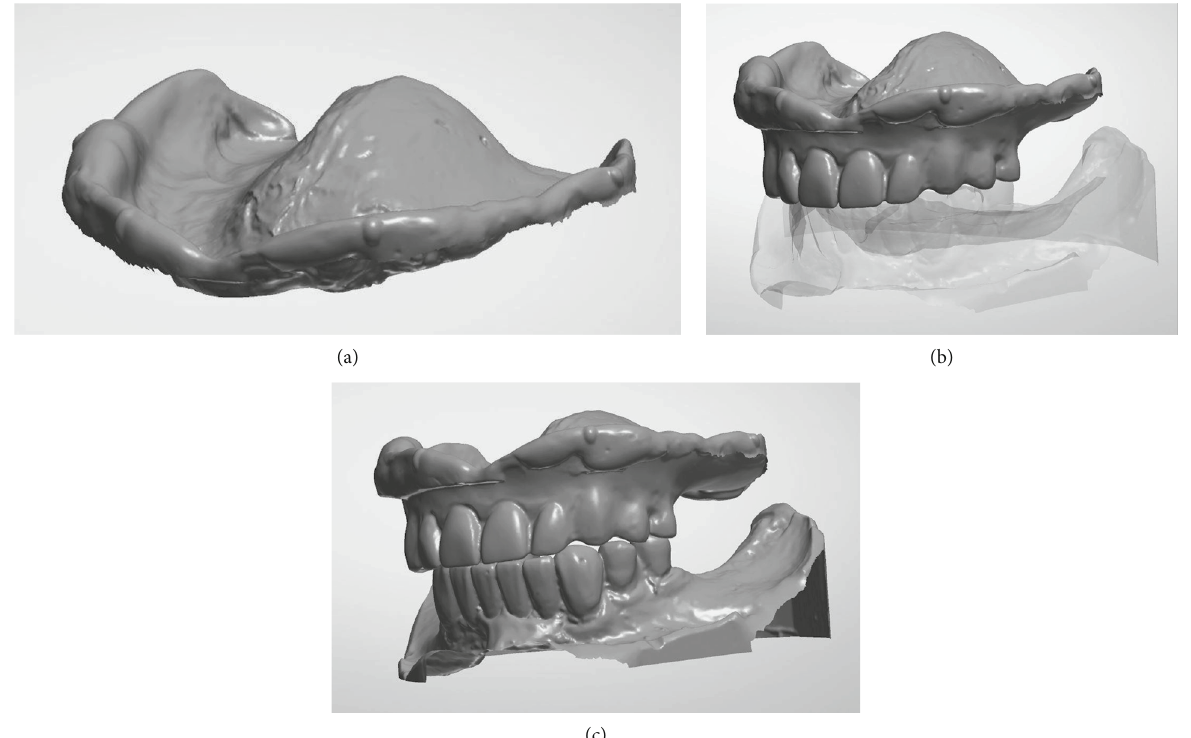
Figure 2: (a) Base area scan of the upper full denture. (b) Scan of the entire upper full denture. (c) Matched scans of the upper full denture and lower jaw.